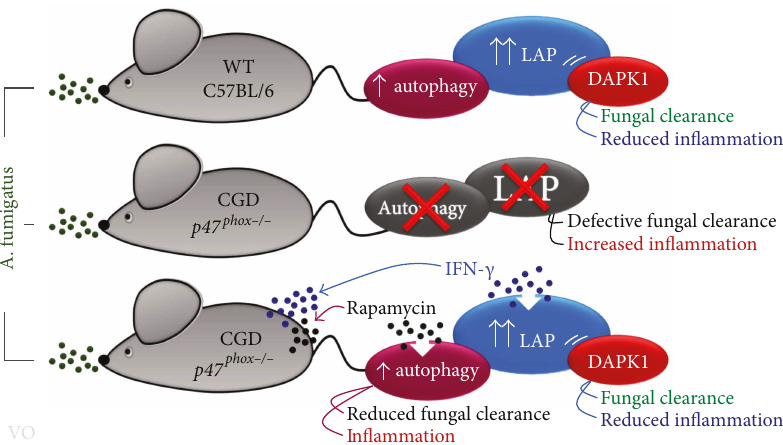
Figure 2: Proposed model of cross-regulation between LAP and canonical autophagy in p47 phox − / − mice. The fi gure shows that both autophagy and LAP are defective in p47 phox − / − mice. Rapamycin, a known inducer of canonical autophagy, failed to promote fungal clearance and reduce in fl ammation when administered to CGD mice as opposed to IFN- γ that promoted fungal clearance and reduced pathogenic in fl ammation by inducing the LAP/DAPK1 pathway. Thus, canonical autophagy and LAP are distinct pathways in Aspergillus infection, and LAP, more than canonical autophagy, is required for optimal antifungal resistance. CGD: chronic granulomatous disease; DAPK1: death-associated protein kinase 1; IFN- γ : interferon gamma; LAP: LC3-associated phagocytosis; WT: wild